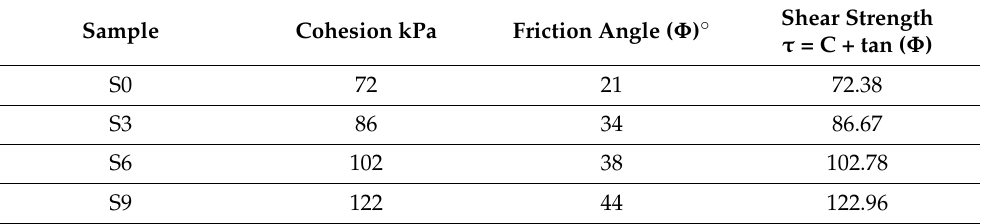
Table 3. Effects of lime and cement kiln dust on shear strength parameters (C and Φ